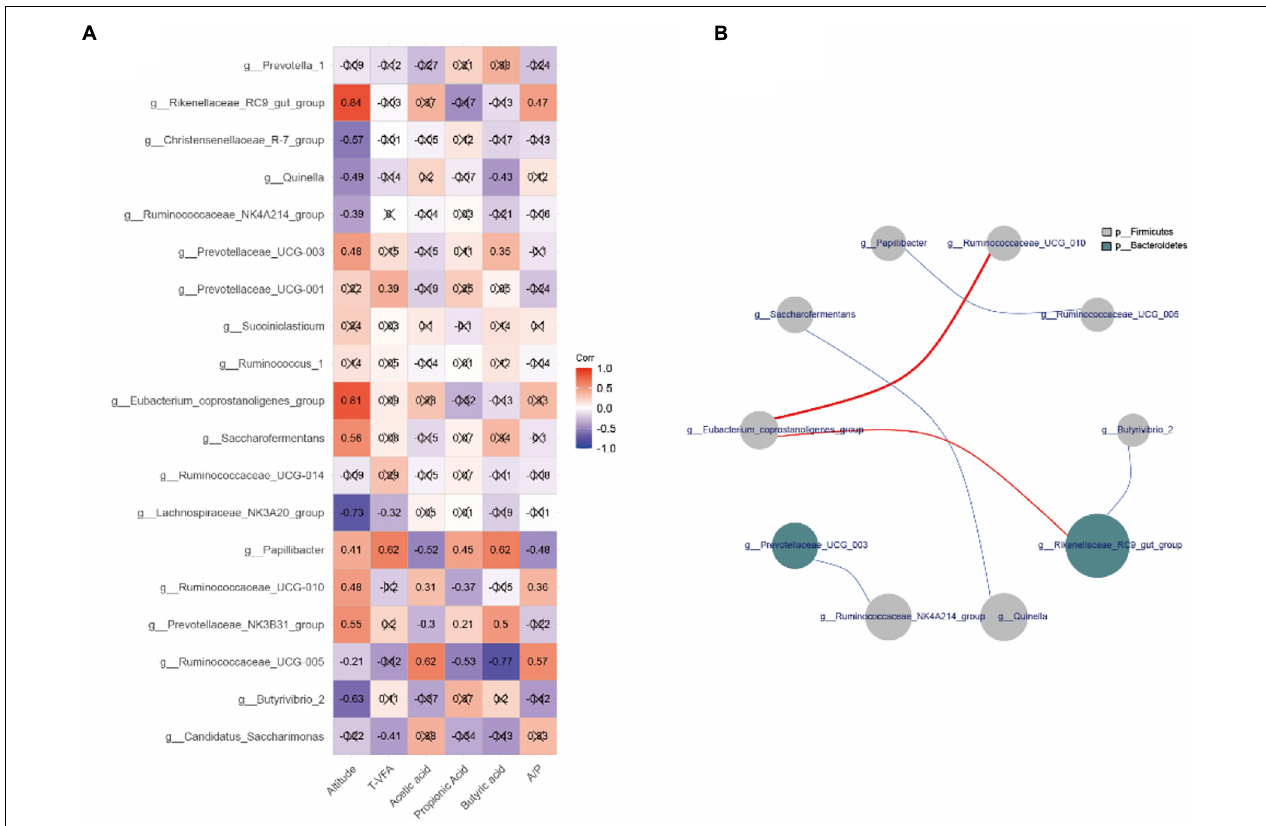
FIGURE 4 | Correlation analysis of rumen genera in yaks inhabiting regions located at distinct altitudes. (A) Correlation between the top 20 relative abundances of genera, fermentation parameters, and altitude. (B) Interaction among the top 20 relative abundances at genus level. Red represents a positive correlation and blue a negative correlation. The number represents the correlation coefficient. The × sign represents p > 0.05. The size and color of the circle represent the relative abundance of the respective genus and the phylum.